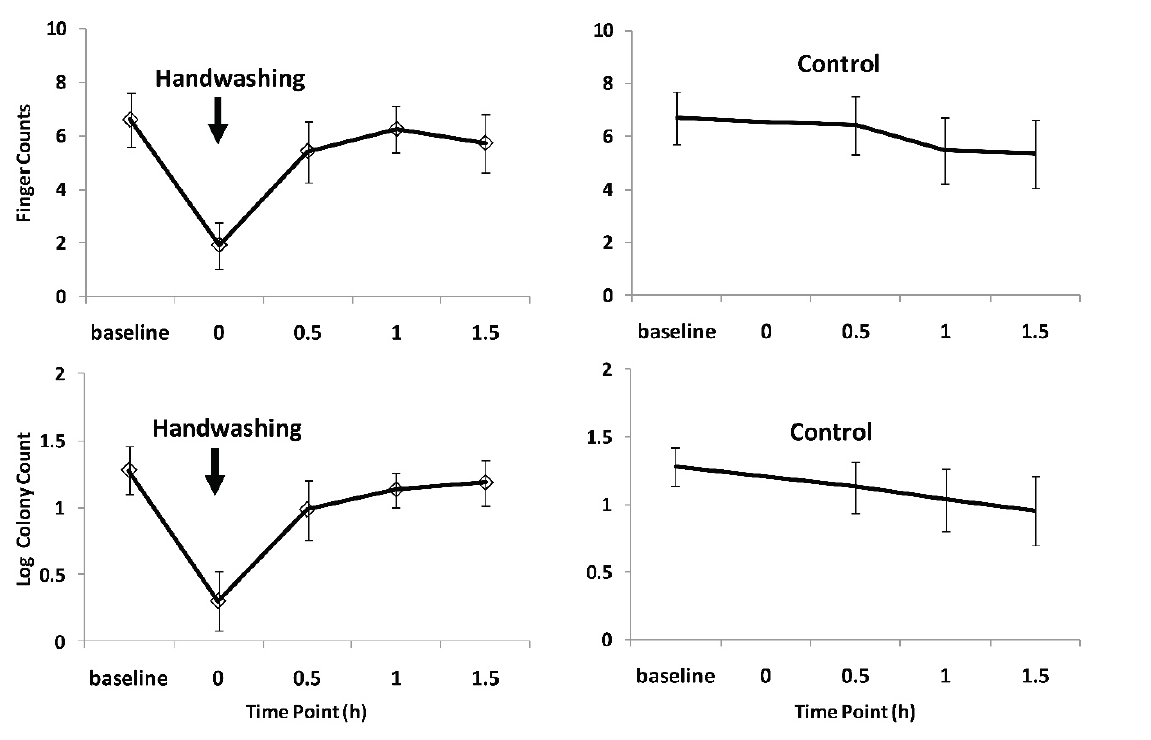
Figure 2. Effect of handwashing with soap on Enterococcus contamination of finger